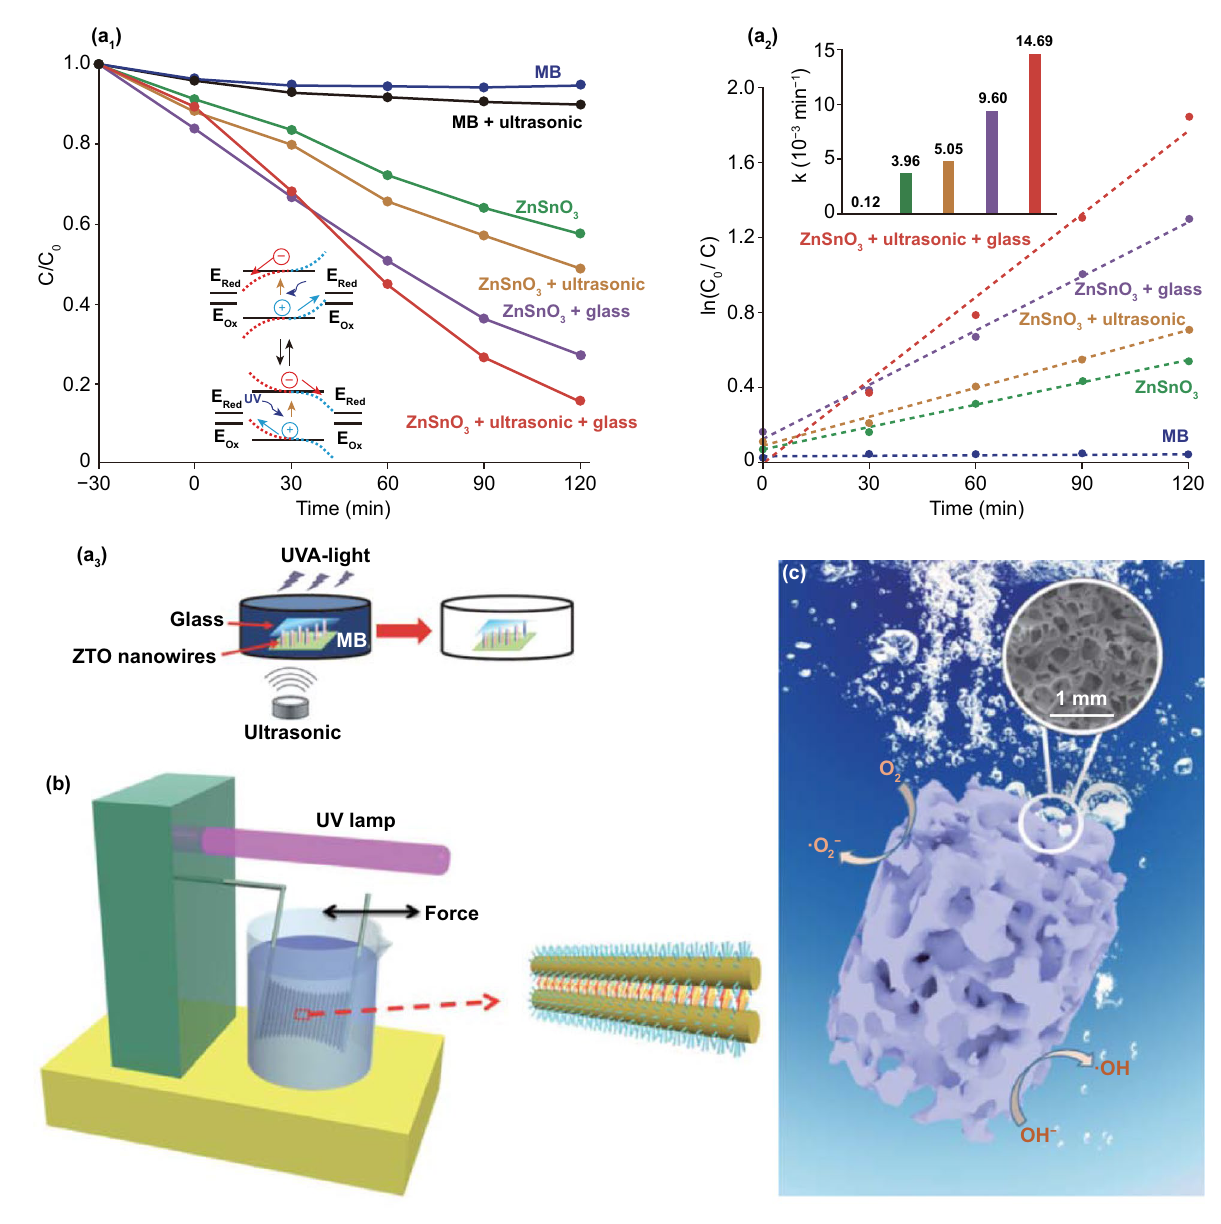
Fig. 8 a Photocatalytic results of ZTO nanowire arrays under various stresses. Reproduced with permission [89]. Copyright 2016, American Ceramic Society. b The degradation of MB solution by the piezo‑photocatalytic activity of ZnO nanowires/C fibers under UV irradiation and periodically applied force. Reproduced with permission [88]. Copyright 2015, Elsevier. c Schematic of porous piezo‑catalysis process in BTO– PDMS porous foam. Reproduced with permission [37]. Copyright 2019, American Chemical